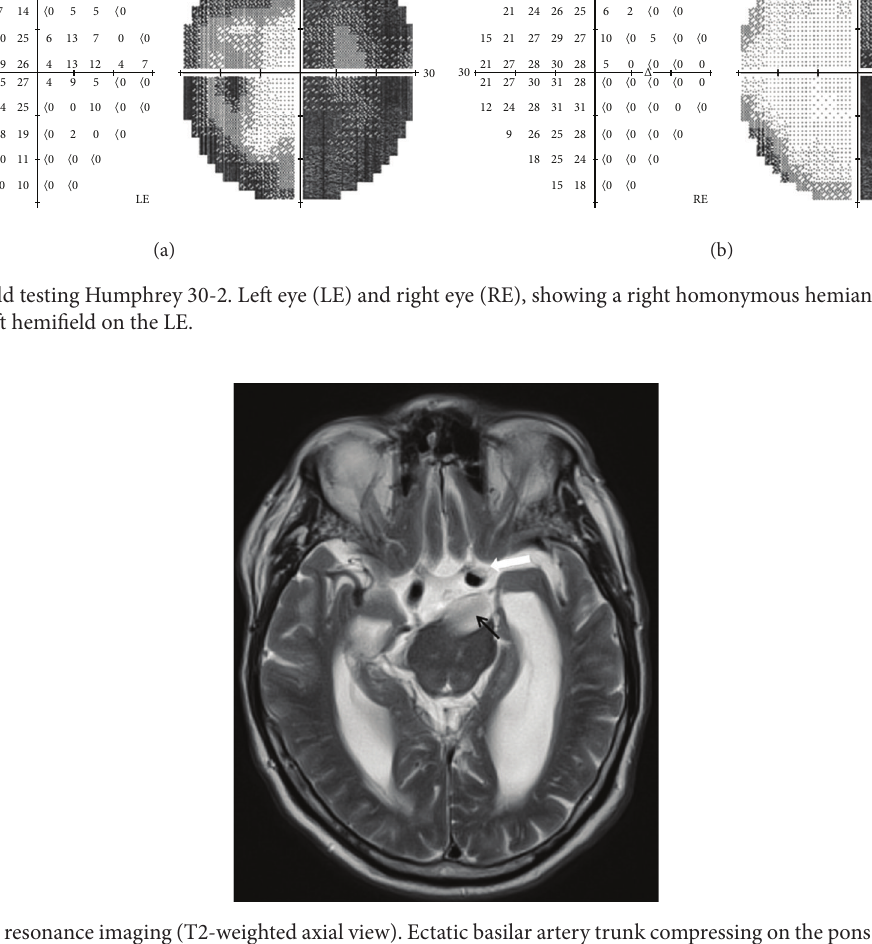
Figure 2: Magnetic resonance imaging (T2-weighted axial view). Ectatic basilar artery trunk compressing on the pons and the retrochiasmal pathway (black arrow depicting lumen of the basilar artery). Note the displaced internal carotid artery adjacent to the left optic nerve (white arrow).